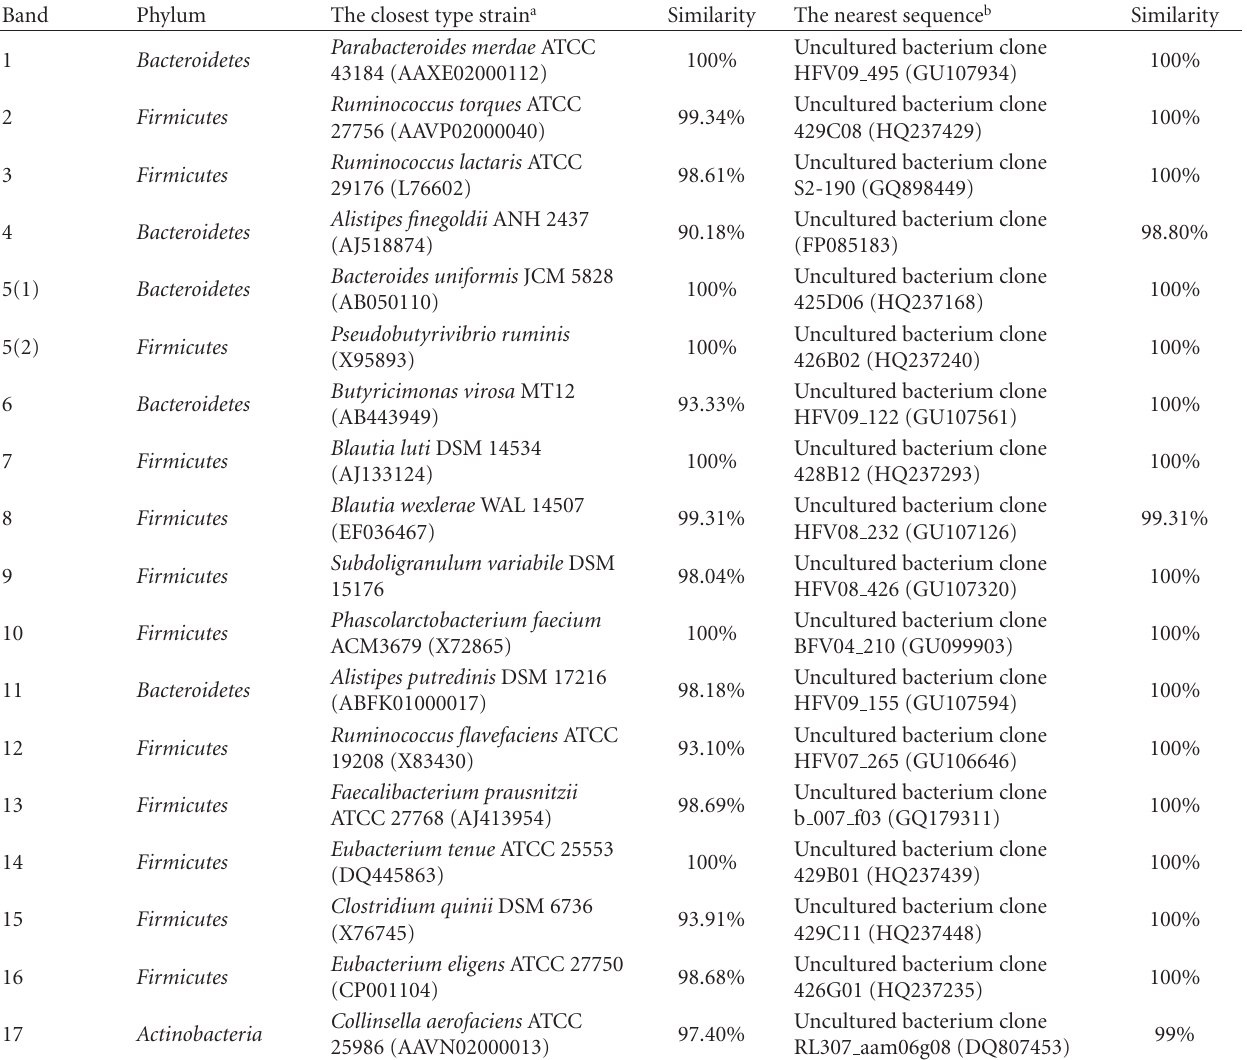
Table 2: The identification of the excised DGGE bands obtained from fecal samples of individual A in di ff erent medium at zero time and after 18 hours. The position of each band in gel profile is shown in Figure 1(a). The numbers in parentheses refer to GenBank accession